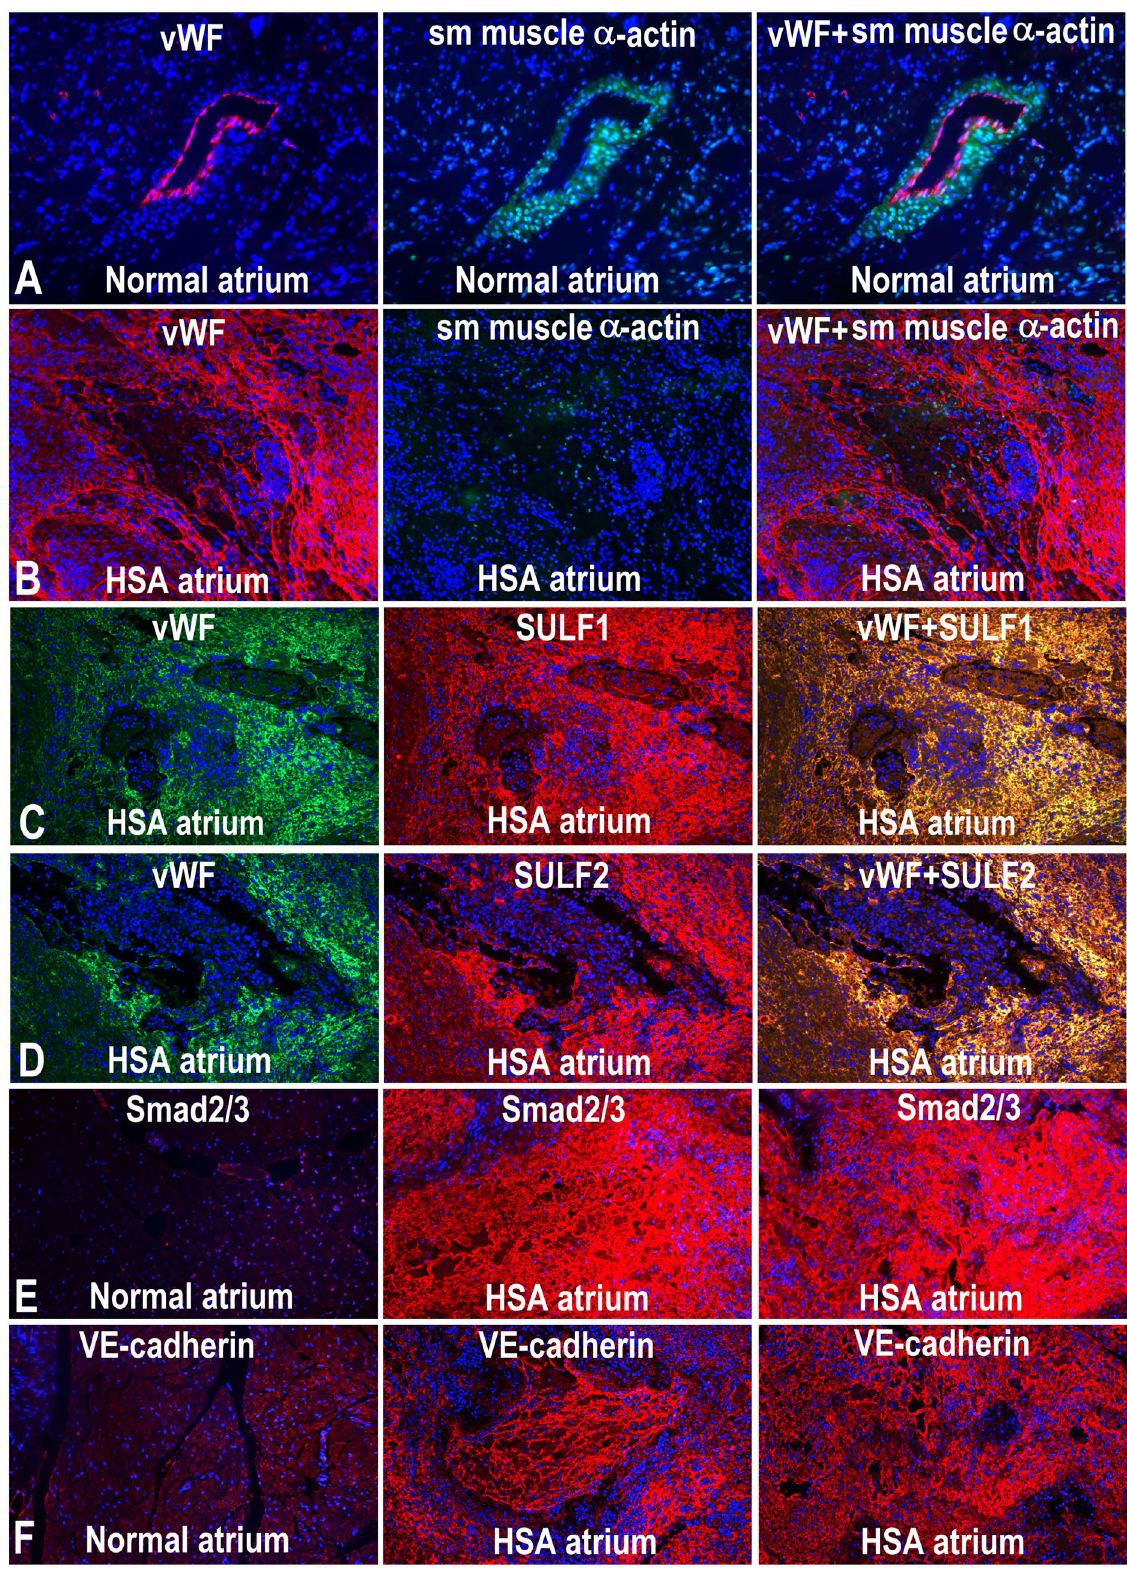
Figure 6. Pattern of vWF and smooth muscle α-actin in a blood vessel of normal unaffected (A) and haemangiosarcomic right atrium (B) determined by double immunofluorescence procedure. Double immunofluorescence also demonstrates co-expression of both SULF1 (C) and SULF2 (D) with vWF as well as markedly increased expression of Smad2/3 in haemangiosarcomal atria (HSA) unlike the control atrium (E) as is also the case for markedly increased VE-cadherin in HSA (F) in such